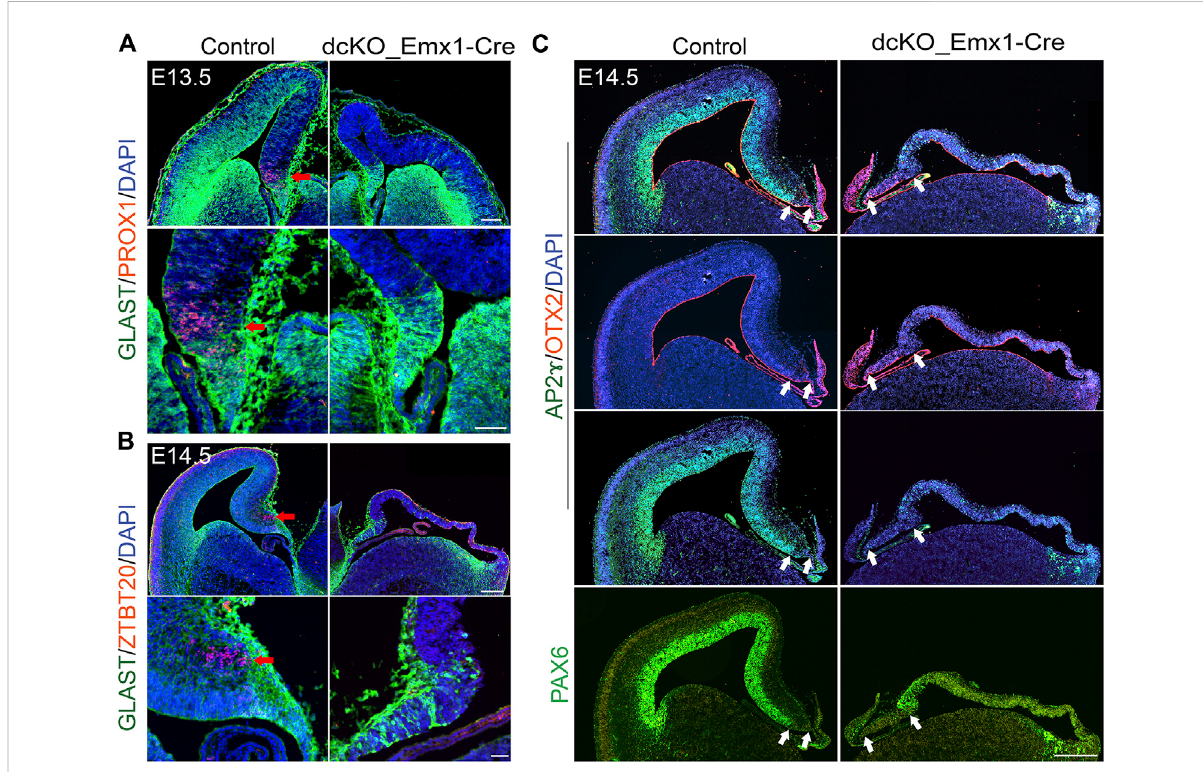
FIGURE 4 LossofBAFindTelperturbshippocampal formationandneocorticalpatterning. (A) Immunohistochemicalmicrographsshowinghemi-section of the control and dcKO_Emx1-Cre mouse brain at E13.5 stained with GLAST and PROX1 antibodies. Panels of close-up images highlight the presence and absence of the PROX1+ dentate gyrus cells in the control and BAF complex mutant medial pallium, respectively. Red arrow points to PROX1 staining. (B) Micrographs showing hemi-section of the E14.5 mouse brain stained with GLAST and ZBTB20 antibodies in control and dcKO_Emx1-Cre . Panels of close-up images highlight the presence and absence of the ZBTB20 + hippocampal neurons in the control and BAF complex mutant hippocampal primordium, respectively. Red arrow points to ZBTB20 staining. (C) Images showing profound loss of cortical mass and patterning associated with the expanded hem in the E14.5 dcKO_Emx1-Cre dTel as compared with control. The applied antibodies AP2 ɣ and PAX6 stain the cortical neuroepithelium/ventricular zone to reveal the unstained cortical hem, while the hem is stained by OTX2. White arrows indicate the size ofthe cortical hem. Sections are counterstainedwith DAPI (blue). Scale bars = 250 µm [in upper panel of (A) ],50 µm [in lower panel of (A) ], 500 µm [in upper panel of (B) ], 50 µm [in lower panel of (B) ], 500 µm (C)